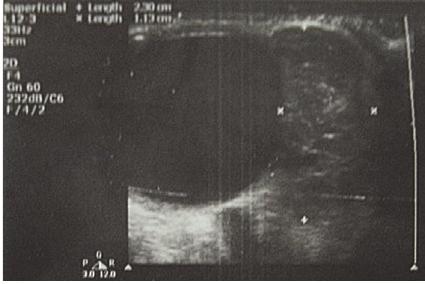
Figure 2: USG B-scan of orbit showing heterogenous mass in the extraconal compartment close to the insertion of the medial rectus.